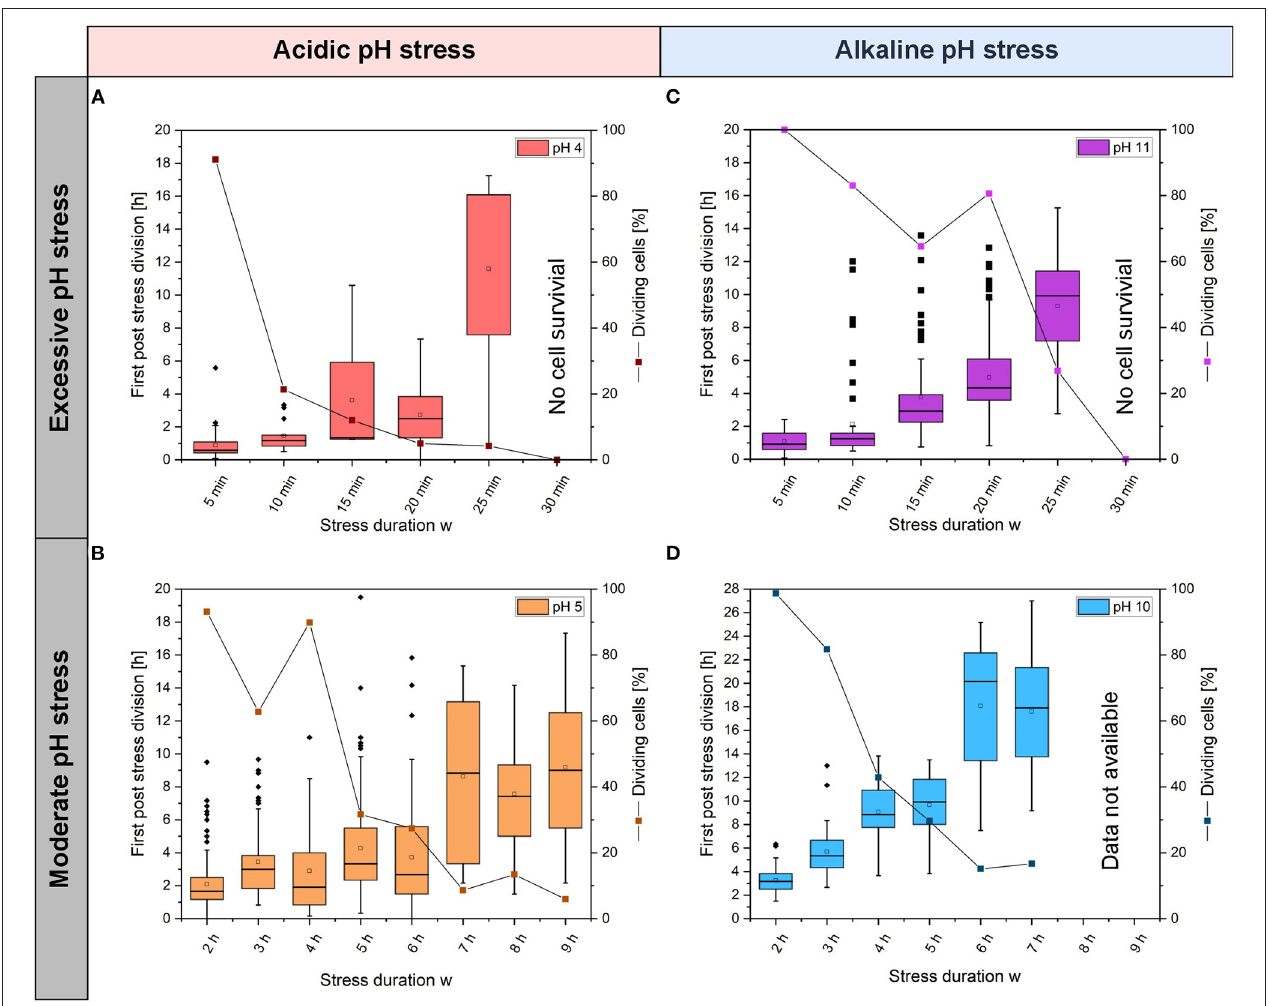
FIGURE 4 | Distributions for the times of first post-stress divisions of single cells and viabilities after acidic (A) pH 4 and (B) pH 5 stress pulses and after alkaline; (C) pH 11 and (D) pH 10 stress pulses. The boxplots show the distribution of the first post-stress division, where the longitudinal bar within the box indicates the median of the first post-stress division. The deviation, also called whisker, shows the upper and lower 25% of the first-post-stress division. In addition, outliers are marked with a dot. On average, 97 single cells (min = 38, max = 181) were counted for each pH and stress duration w (see Supplementary Table S1